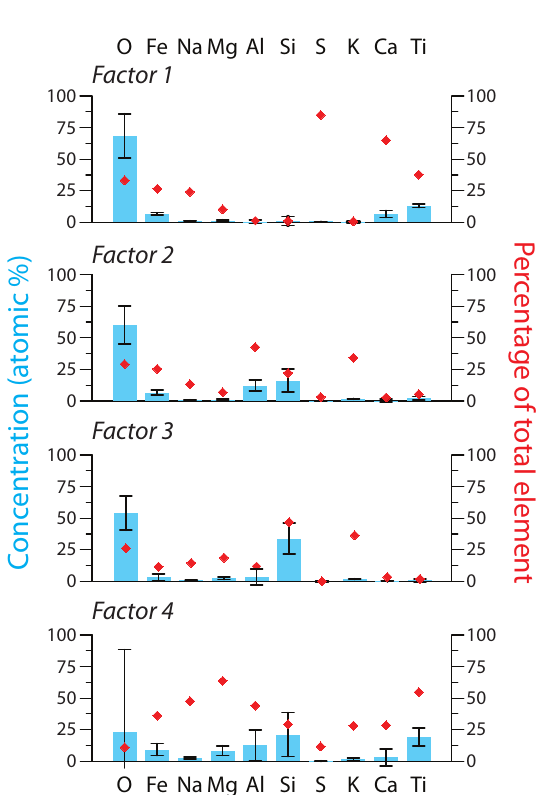
Fig. 6. Elemental profiles of the four “mineral assemblages” con- tributing to isotopic composition of sulfate produced from SO 2 ox- idation, identified by PMF analysis. Columns with 1 σ error bars (standard deviation of the results of 20 model runs) correspond to the left-hand axis and show the concentration of the element in atomic percent, while diamonds correspond to the right-hand axis and show the percentage of the element’s total concentration that is present in a particular mineral assemblage.